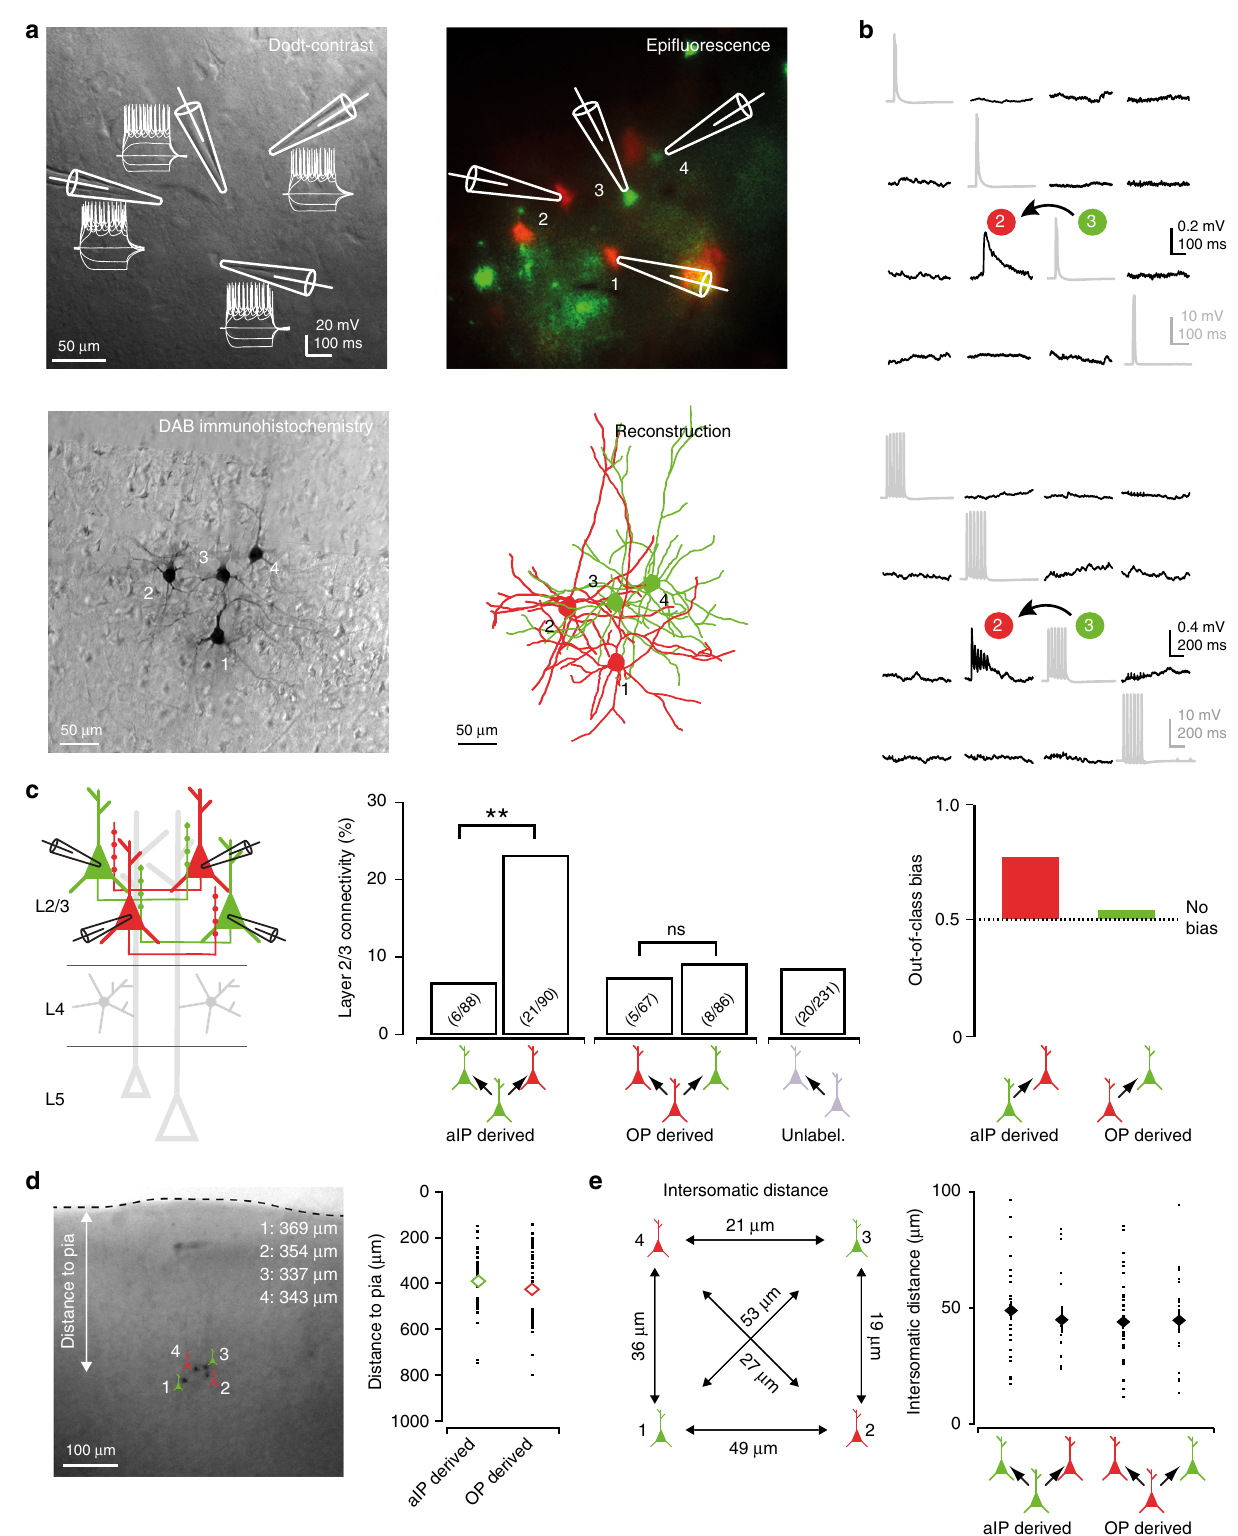
Fig. 5 aIP-derived L2/3 neurons exhibit speci fi c intralaminar connections. a Quadruplet whole-cell patch-clamp recording from aIP-derived and OP-derived neurons in L2/3. b Intralaminar connectivity was assessed with single (top) and trains (bottom) of pre-synaptic action potentials. c aIP-derived L2/3 pyramidal neurons exhibited a higher probability of connecting to neighboring L2/3 pyramidal neurons derived from OPs, rather than from aIPs (aIP to aIP: 6.8%, aIP to OP: 23.3%, OP to OP: 7.5%, OP to aIP: 9.3%; aIP to OP: p = 0.003, Fisher ’ s exact test), representing an out-of-class connectivity bias for aIP- derived L2/3 neurons. d Intralaminar connectivity was sampled without spatial bias, as the recorded aIP- and OP-derived neurons had comparable distances from the pial surface (right; p = 0.24, t -test, n = 43 and 45). e Intersomatic distances for each category of cell-cell comparison (right; p = 0.8, Kruskal – Wallis test, n = 25, 15, 37, and 20). Error bars represent standard error of the mean. Source data are provided as a Source Data fi